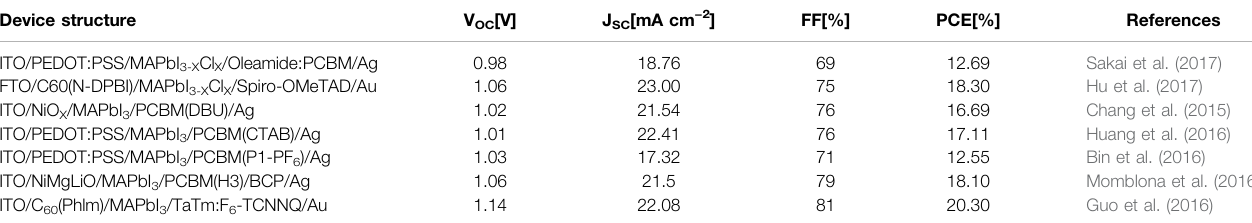
TABLE 3 | Parameters of PSCs containing organic doped ETL. Device structure